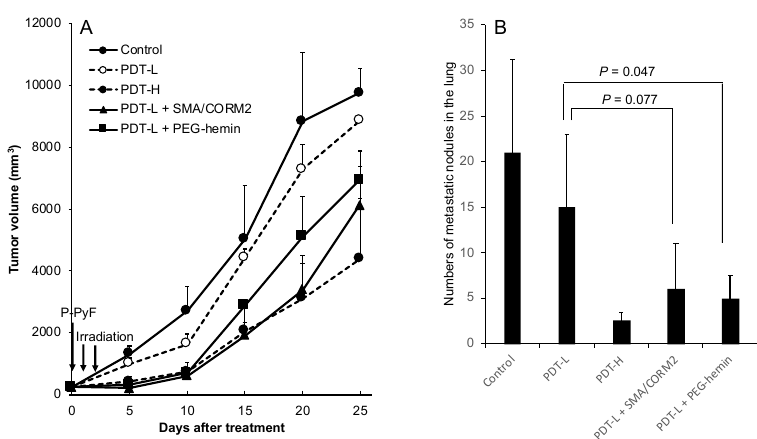
Figure 3. Enhanced therapeutic effect of P-PyF and CO generators under the photodynamic therapy (PDT) method on C26 tumors. Two concentrations (2 and 5 mg/kg, PDT-L and PDT-H, respectively) of P-PyF were injected i.v. when the tumor diameters were measured as about 8–10 mm. PEG-hemin and SMA/CORM2 were injected i.v., respectively. Then, 24 and 2 h later, P-PyF was injected i.v., followed by light irradiation (120 mW/cm 2 , 5 min, 36 J/cm 2 ). Tumor growth was measured every five days. ( A ) Original implanted primary tumor and ( B ) metastatic tumor nodules in the lung were suppressed by PDT dose-dependently, and low-dose PDT, when combined with CO generators, exhibited a similar antitumor effect as high-dose PDT. Data are means ± SD; n = 4–8. See text for details.